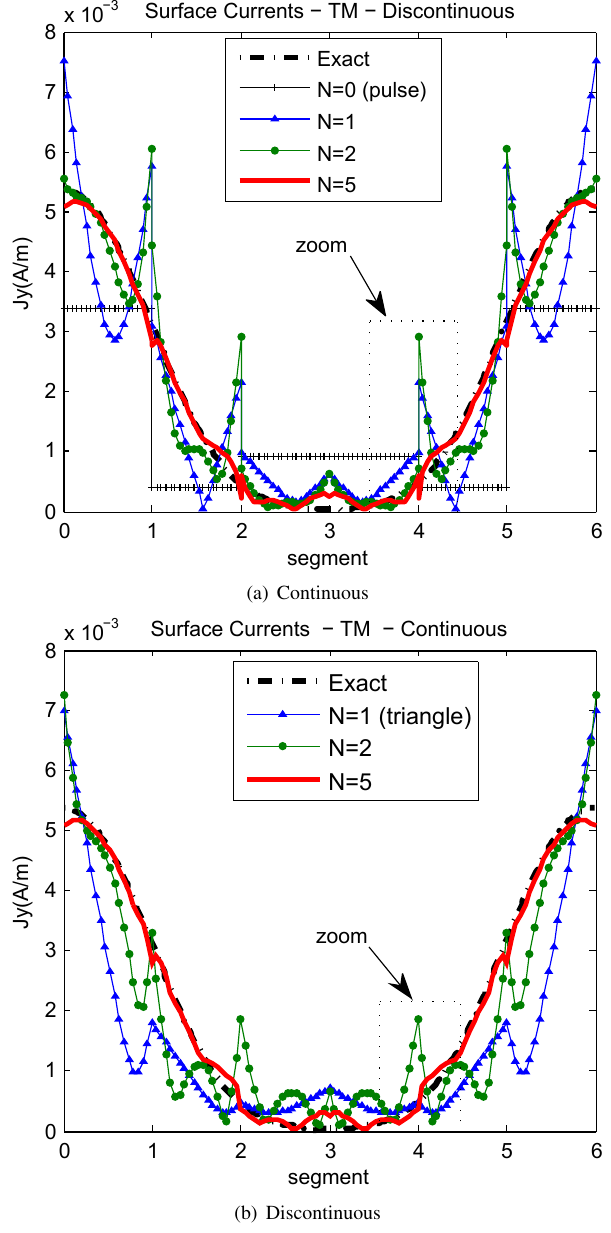
Figure 8: (TM polarization) Surface current estimation with different orders for r = λ , L =